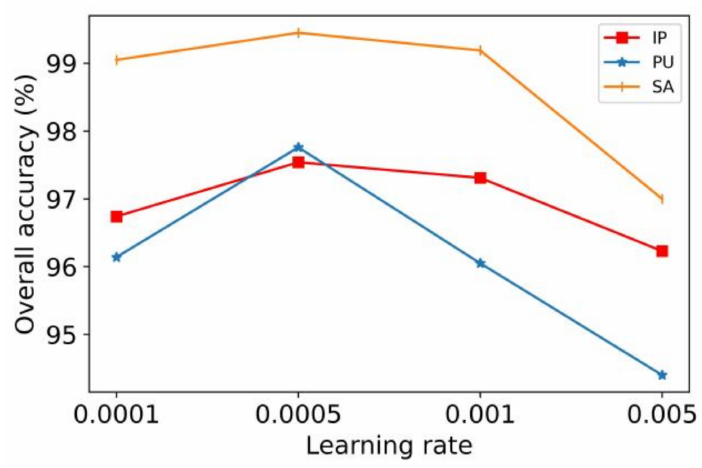
Figure 10. Performance of the proposed method with different learning